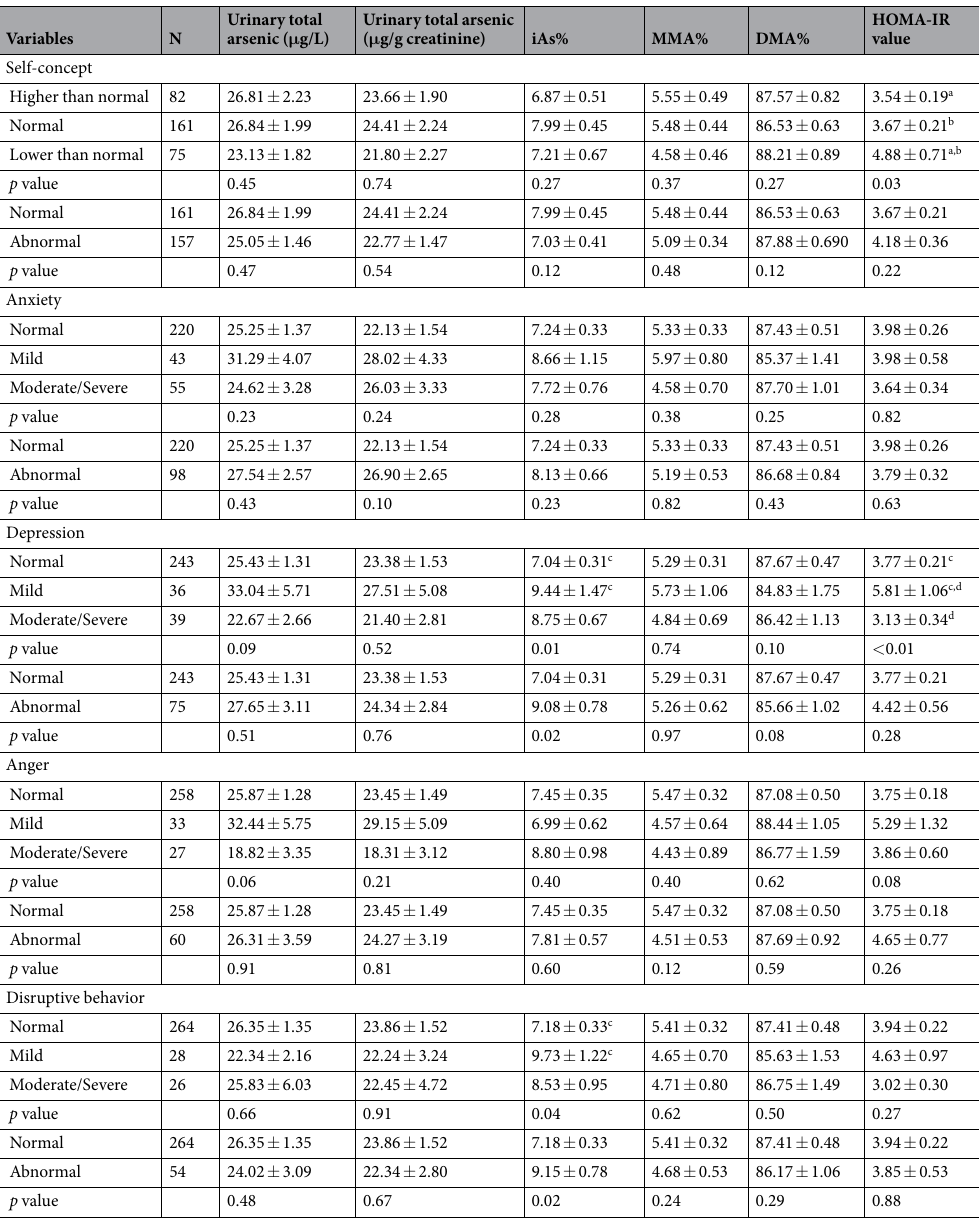
Table 4. Distribution of urinary total arsenic and HOMA-IR values according to psychological characteristics in junior high school students. aSelf-concept higher than normal vs. Self-concept lower than normal, p < 0.05; b Normal self-concept vs. Self-concept lower than normal, p < 0.05; c Normal depression vs. Mild depression, p < 0.05; d Mild depression vs. Moderate or Severe depression, p <